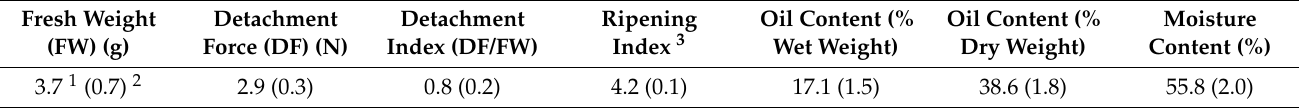
Table 2. Characterisation of the fruit on the trial plot ( n = 100).